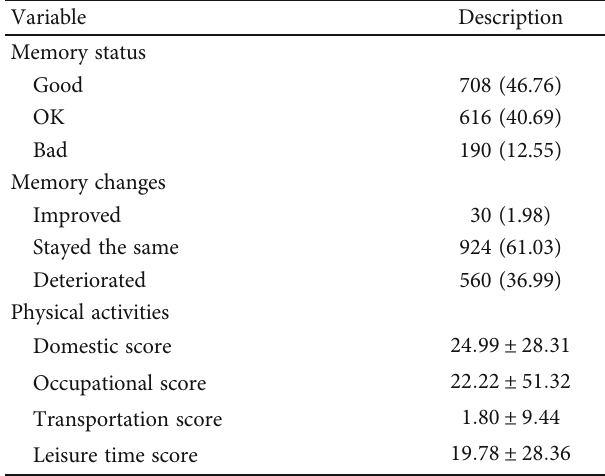
Table 1: The characteristics of the